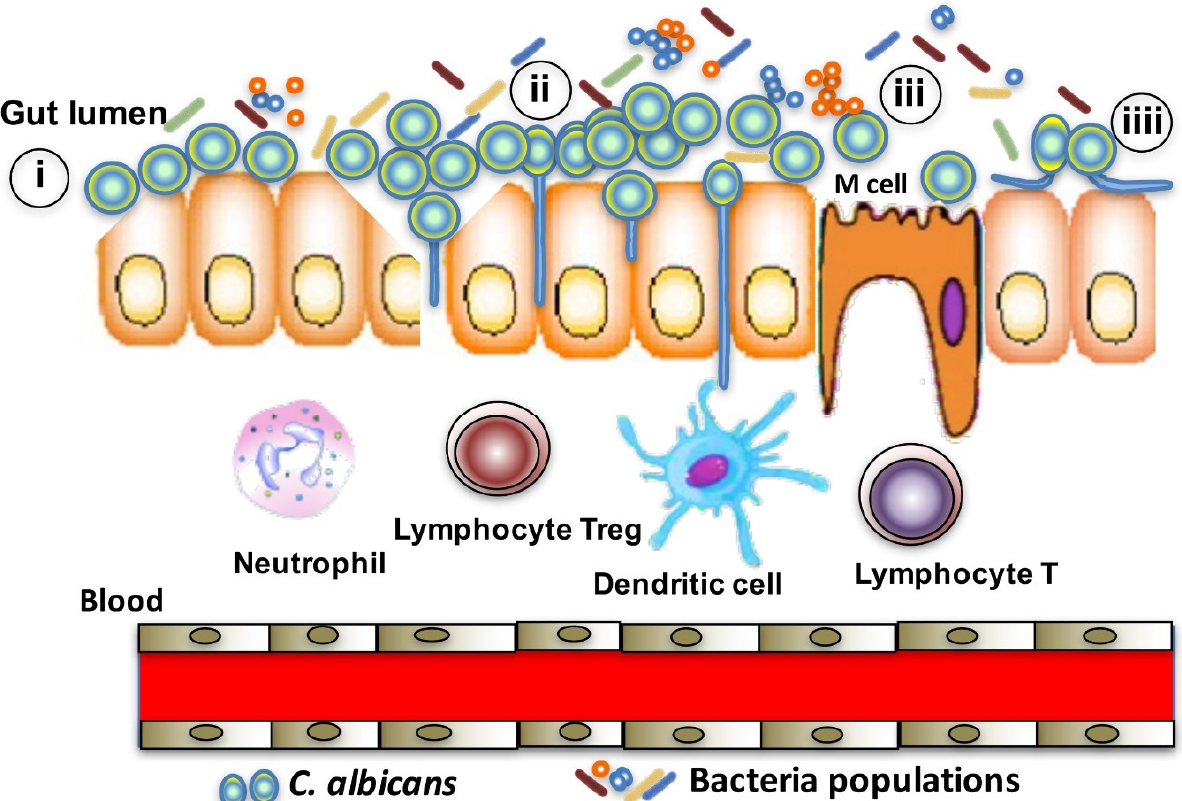
Figure 1. Schematic representation of some mechanisms that promote the passage of C. albicans through the intestinal barrier. (i) Dysbiosis, associated or not with inflammatory lesions of the intestinal mucosa and effraction of the intestinal barrier; (ii) a decrease in watertightness of the epithelium (tight junctions) and mucus layer; (iii) endocytosis by M cells (microfold cells) situated in the intestinal epithelium, dendritic cells or macrophages; (iiii) endocytosis by epithelial cells, such as the interaction between Als3 or Ssa1 on the hyphal surface of C. albicans and epithelial cells of E- cadherin.